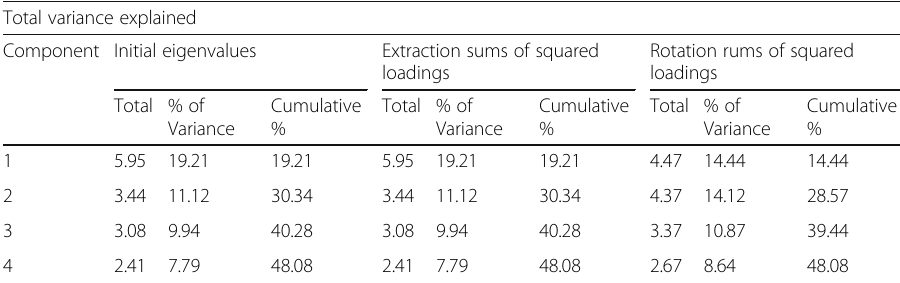
Table 4 Total variance explained Total variance explained Component Initial